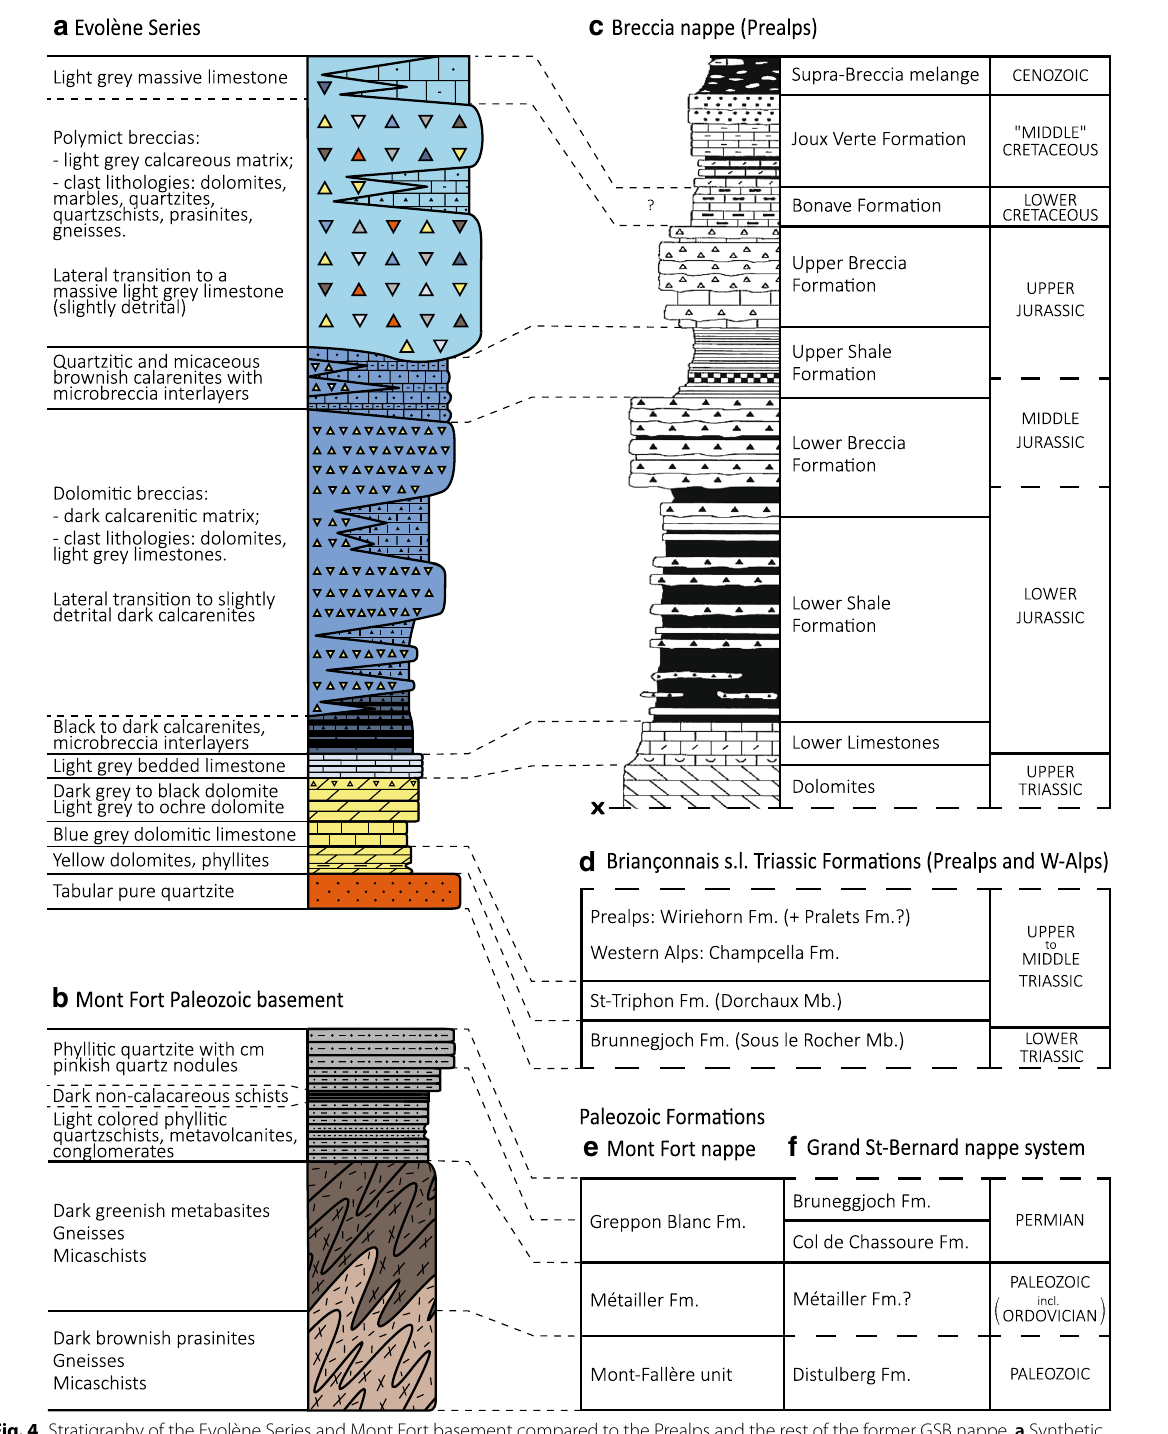
Fig. 4 Stratigraphy of the Evolène Series and Mont Fort basement compared to the Prealps and the rest of the former GSB nappe. a Synthetic stratigraphic column of the Evolène Series. b Synthetic stratigraphic column of the Mont Fort Paleozoic basement. c Synthetic stratigraphic column of the Breccia nappe in the Prealps (modified after Dall’Agnolo 1997, 2000). d Triassic Formations of the Briançonnais s.l. domain (Prealps and Western Alps). Only the Briançonnais Triassic Formations having an observed equivalent in the Mont Fort nappe are listed. e Geological Formations defined in the Mont Fort Paleozoic basement. f Geological Formations defined in the GSB Paleozoic basements. Scales in ( a ) to ( e ) are different and